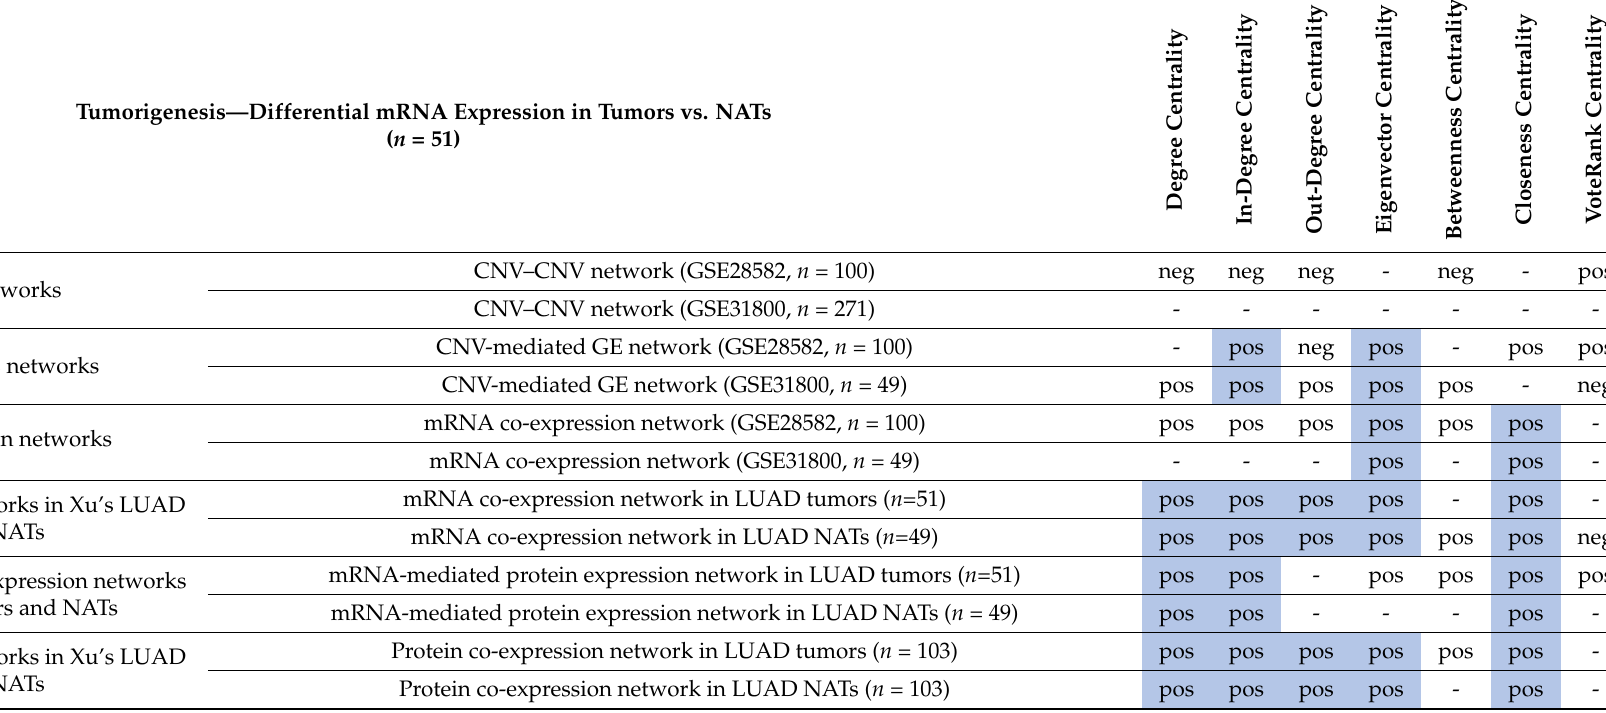
Table 2. Correlations between seven centralities of the selected networks and t statistics of differential mRNA expression in tumors vs. NATs in Xu’s LUAD cohort [39]. pos: Pearson’s correlation coefficient r > 0 and p < 0.05; neg: r < 0 and p < 0.05. The blue color indicates concordant positive